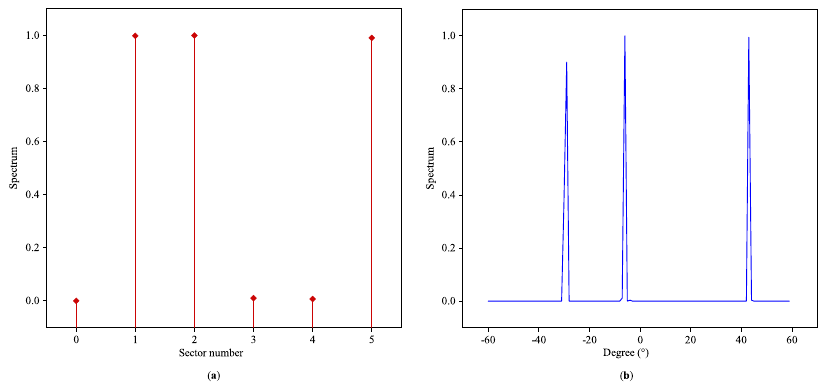
Figure 4. Recovered spatial spectrums for coherent signals from three different angular sectors: ( a ) outputs of the space filter to the signals from the 2th, 3th, and 6th sectors with the directions of ( − 28 ◦ , − 5 ◦ ,44 ◦ ) . ( b ) Outputs of the multi-label classifiers to the signals from the 1th, 2th, and 5th sectors with the directions of ( − 28 ◦ , − 5 ◦ ,44 ◦ ) .